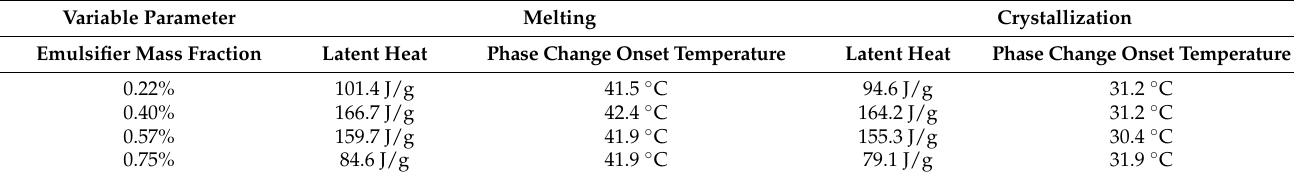
Table 8. Experimental results for changing the mass fraction of emulsifier.